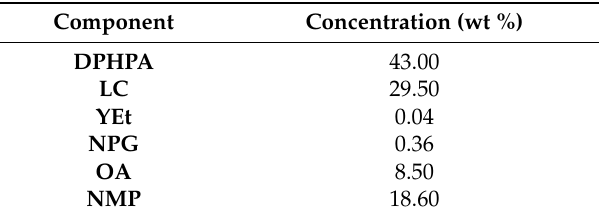
Table 2. Composition of the composite material in wt